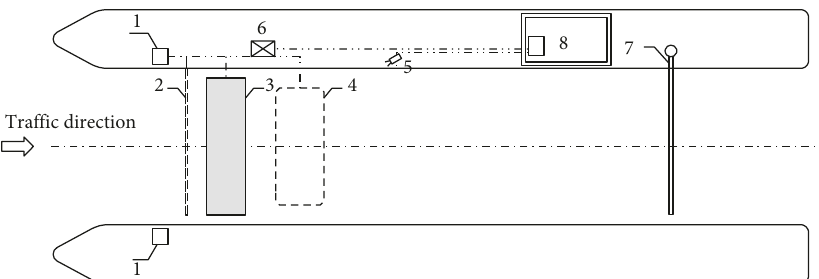
Figure 1: Weigh-in-motion (WIM) system configuration along a toll station exit of the considered expressway. 1: vehicle separator; 2: axle identifier; 3: weighing pad; 4: induction coil sensors; 5: video camera; 6: data processor; 7: stop rail; 8: toll booth. Table 2: Toll fee structure for the initial toll-by-weight policy. Weight